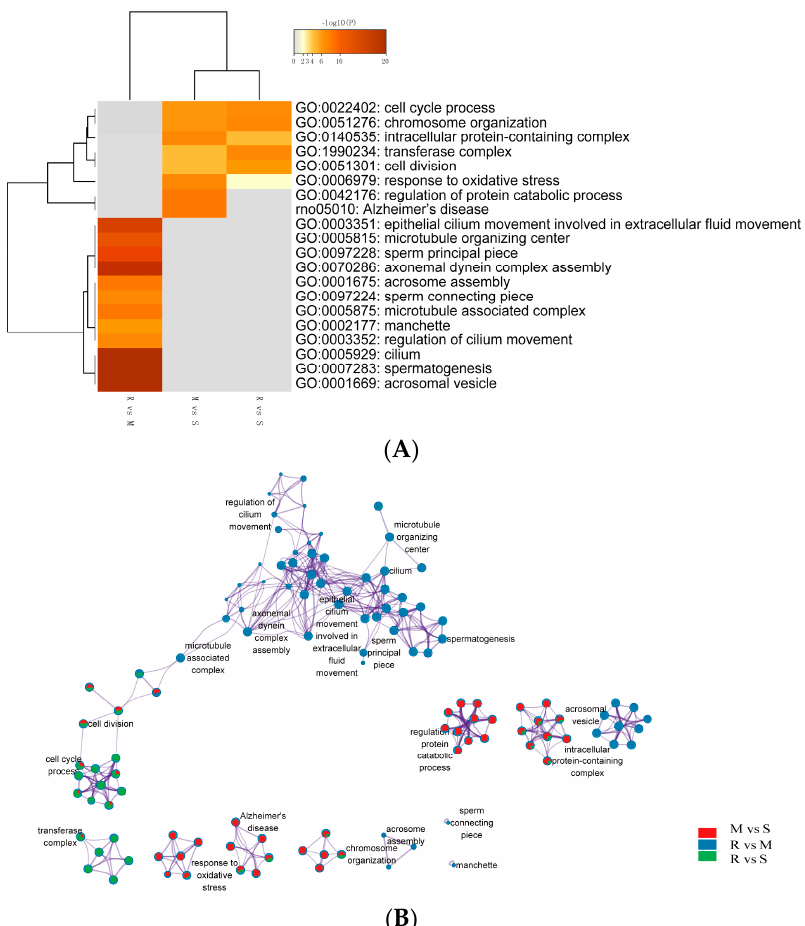
Figure 3. Visualizations of meta-analysis results based on multiple gene lists. ( A ) A heatmap showing the top enrichment clusters, one row per cluster, using a discrete color scale to represent statistical significance; gray color indicates a lack of significance. The categories GO:0022402 (cell cycle process) to GO: 0006979 (response to oxidative stress) are related to M vs. S and R vs. S. While GO:0046176 (regulation of protein catabolic process) and rno: 05010 (Alzheimer’s disease) are enriched exclusively in the M vs. S stage. From GO: 0003351 (epithelial cilium movement involved in extracellular fluid movement) to GO: 0001669 (acrosomal vesicle) are enriched exclusively in the R vs. M stage. ( B ) Enrichment network visualization for results from the three gene lists, where nodes are represented by pie charts indicating their associations with each input study. Cluster labels were manually added. Color code represents the identities of gene lists. The network shows that processes, such as cell division, cell cycle process and chromosome organization, are generally shared among the M vs. S and R vs. S stages. Process regulation of cilium movement and microtubule organizing center and so on are especially enriched between M vs. R (red represents the gene lists between the M vs. S stage; blue represents the M vs. R stage; green represents the R vs. S stage).